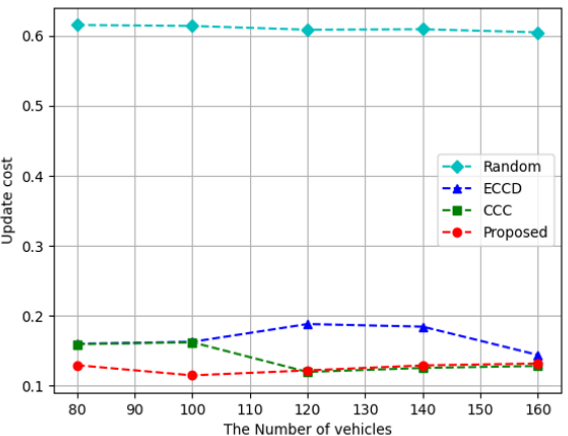
Figure 6. Update cost according to the increase in the number of vehicles.